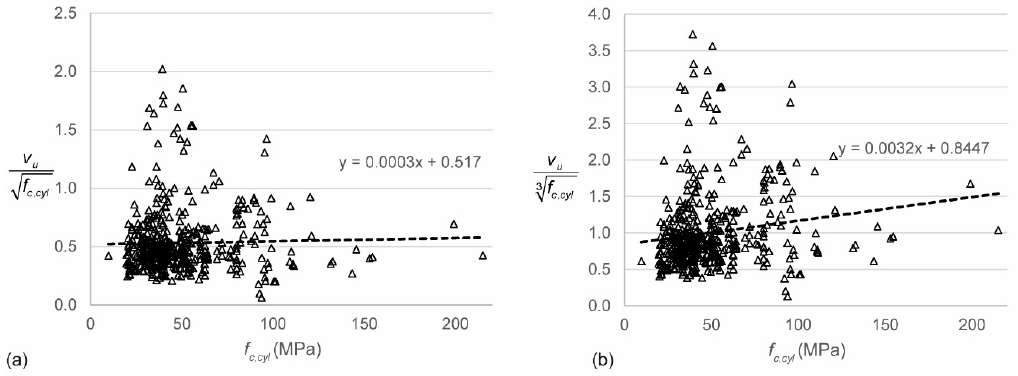
Figure 2. Normalized shear stresses to the concrete compressive strength: ( a ) normalized to the square root; ( b ) normalized to the cube root.